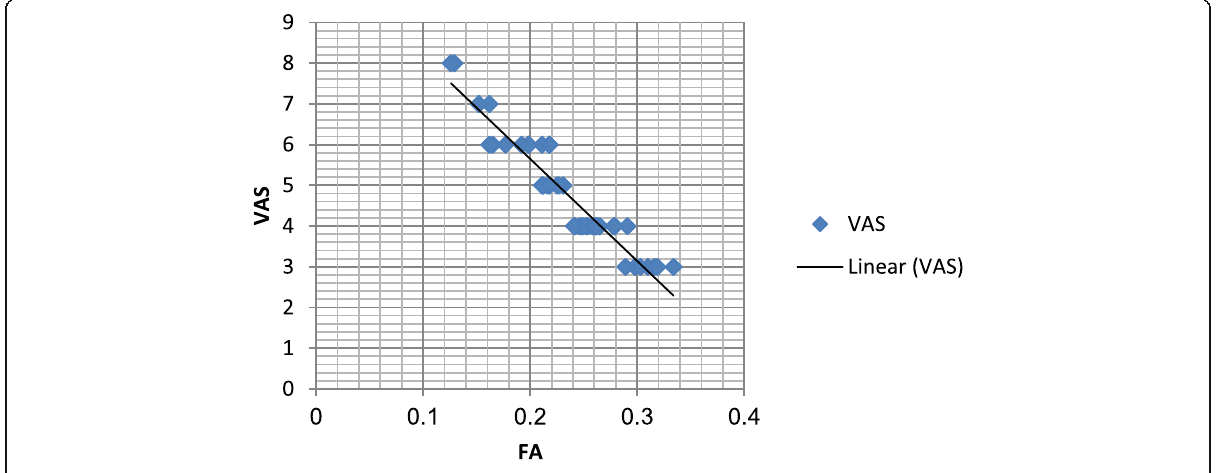
Fig. 4 Correlation between FA and VAS scores for compressed nerves